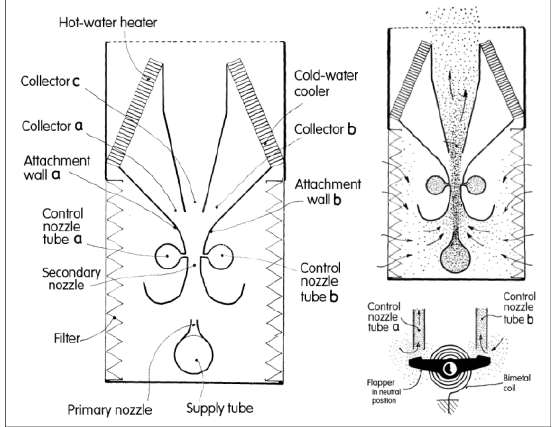
Fig. 8. Application of the Coanda jet attachment flow diverter principle in the water/air terminal unit [10] of induction type, driven by supplied clean air from central plant. At right is the bimetallic thermostat in the neutral, central jet position and the corresponding non-deflected straight jet